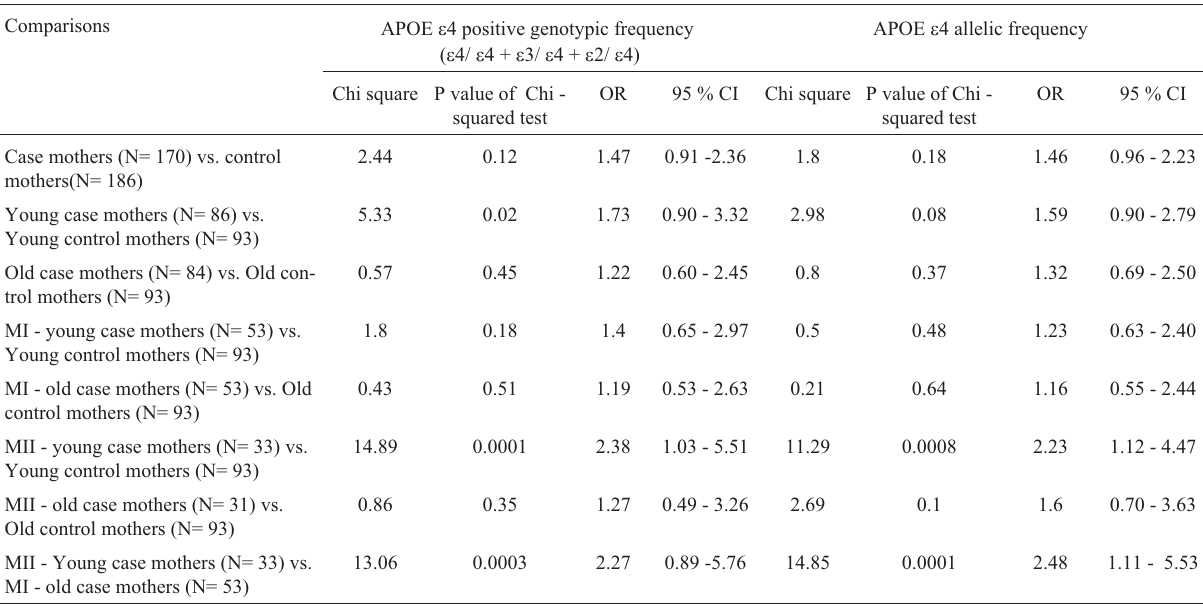
Table 2 - Comparative analysis of APOE (cid:2) 4/- genotypic and (cid:2) 4 allelic frequencies in mothers of DS children and control mothers of karyotypically nor- mal children.